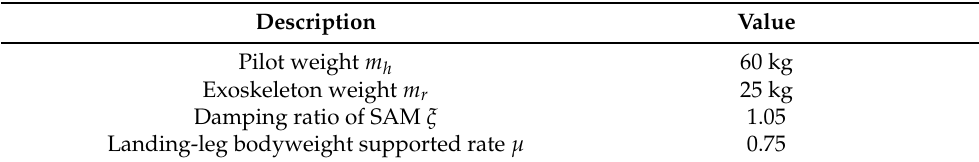
Table 4. Experiment